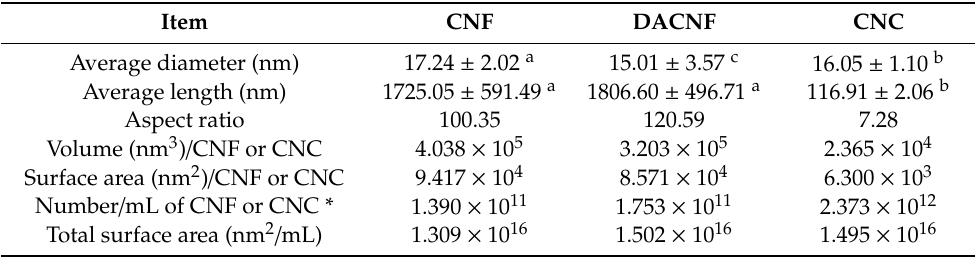
Figure 2. The width and length distribution from TEM of ( A ) width of chitin nanofibers; ( B ) length of chitin nanofibers; ( C ) width of deacetylated chitin nanofibers; ( D ) length of deacetylated chitin nanofibers; ( E ) width of chitin nanocrystals; and ( F ) length of chitin nanocrystals. The average diameter, length, aspect ratio, calculated number and surface area of chitin